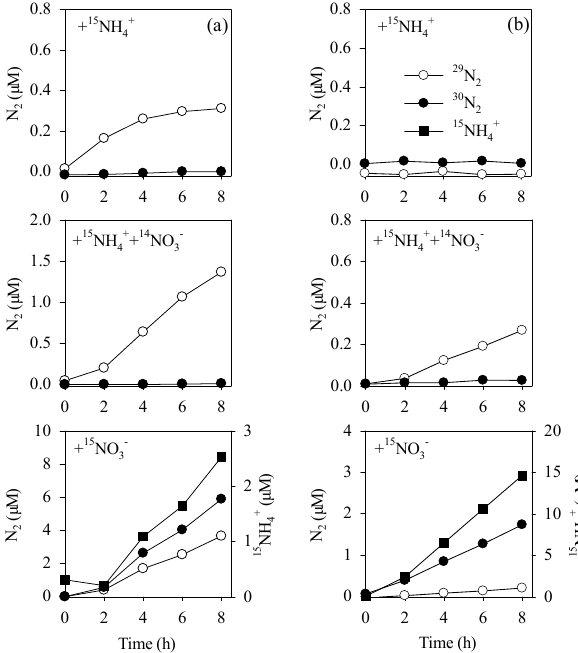
against time in 4